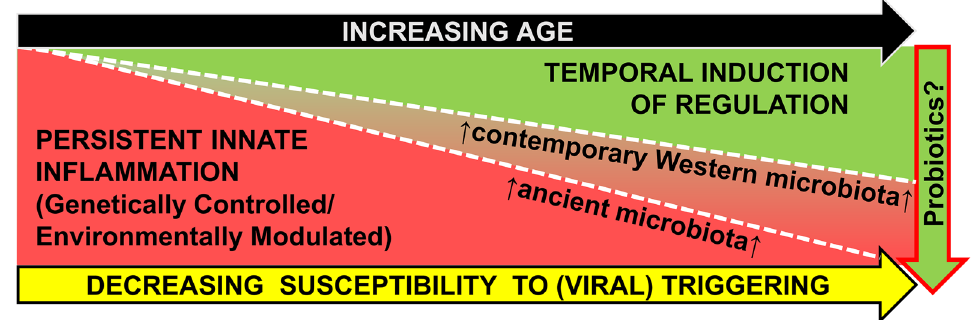
Figure 5. Model mechanism for how a contemporary microbiota influences the age-dependent decline in T1D susceptibility. An elevated innate inflammatory state, that includes hyper-responsiveness to TLR stimulation, is associated T1D susceptibility in human T1D families and diabetic rat models. In human T1D families, this state is independent of the HLA, presence of anti-islet antibodies, and progression of diabetes. In BioBreeding DR rats, this state is independent of insulitis, and disease progression, but is associated with the ability of Kilham’s rat virus to trigger disease progression 35 . This inflammatory state may be the consequence of genetics, diet, and